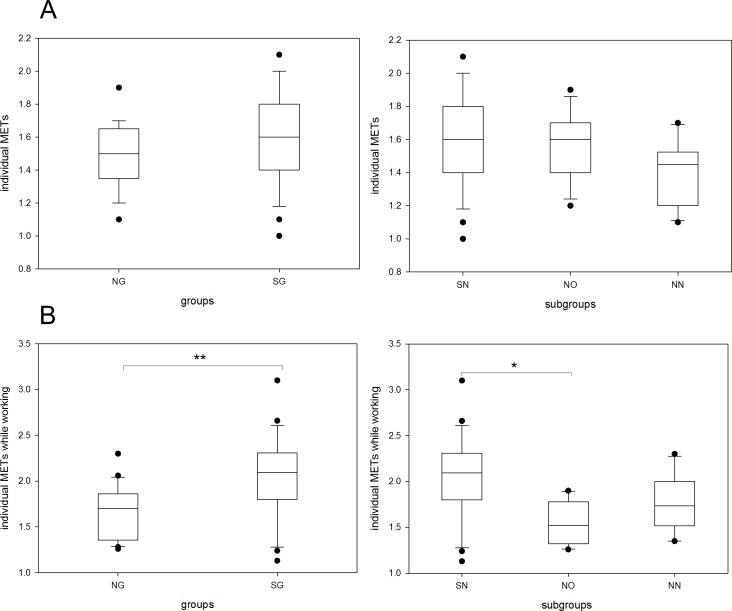
Individual physical activity in metabolic equivalents of task (METs) in shift and non-shift workers and their subgroups.A: induvial physical activity for overall time in METs. B: individual physical activity in METs during the working time The boxes cover the first quartile on the bottom and the third quartile on the top. Whiskers reach from the minimum to the maximum value excluding outliers (illustrated by dots). Shift-working group and shift-working nursing-staff subgroup cover identical cohorts. Working periods were identified using the test subject’s activity journal and analysed separately. The value of subjects’ individual METs was calculated by SWA’s attached software, through a special algorithm. NG, non-shift-working group; SG, shift-working group; SN, shift-working nursing-staff subgroup; NO, non-shift-working office-staff subgroup; NN, non-shift-working nursing-staff subgroup. *p<0.05, **p<0.01.